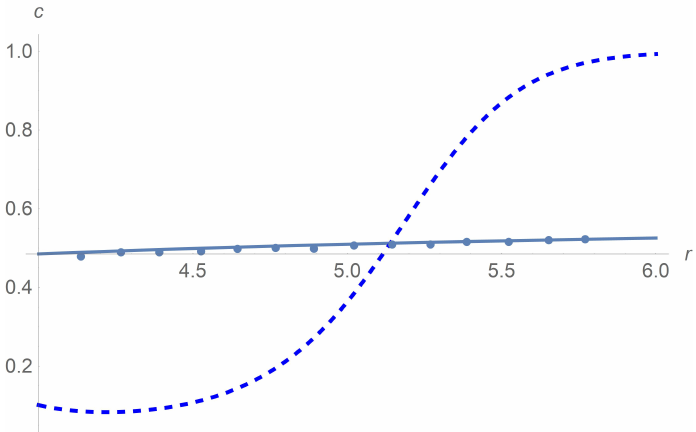
Figure 11. Profiles of mass concentration c . Both the solid line that is based on calculations and dots standing for experimental data [9] correspond to Ω = 10 2 rpm. Agreement between calculations and experiment is achieved by the choice D ∗ ω / ( 2 D ) = 5 × 10 − 5 [ s 2 ] . The dashed line corresponding to calculations reveals the sedimentation effect when we increase Ω to 14 × 10 3 [ rpm ]